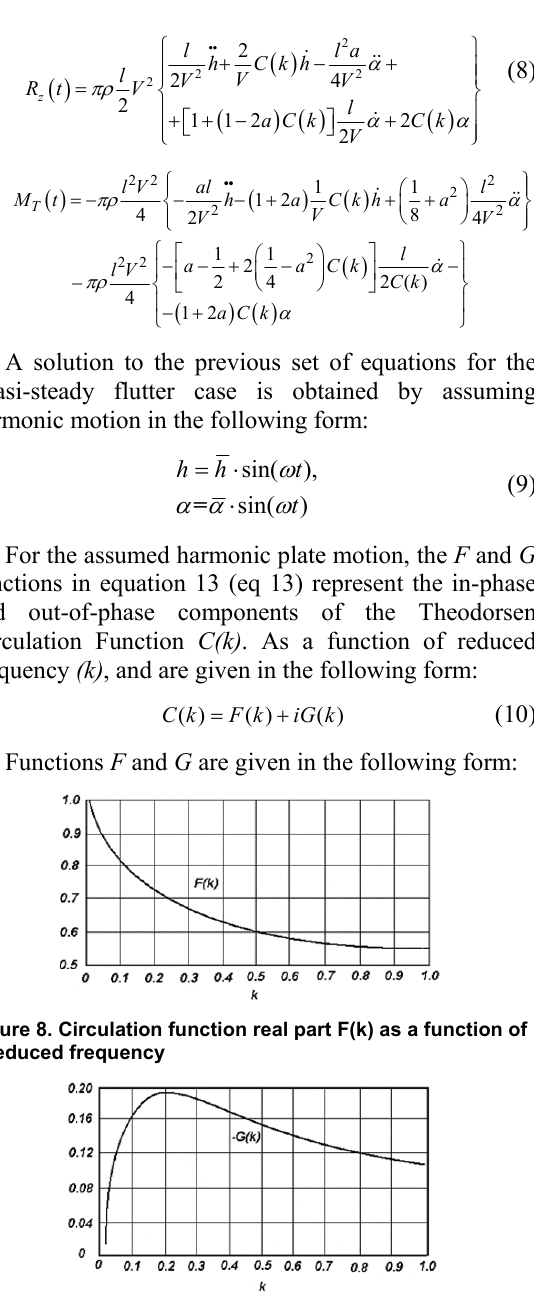
Figure 9. Circulation function real part G(k) as a function of a reduced